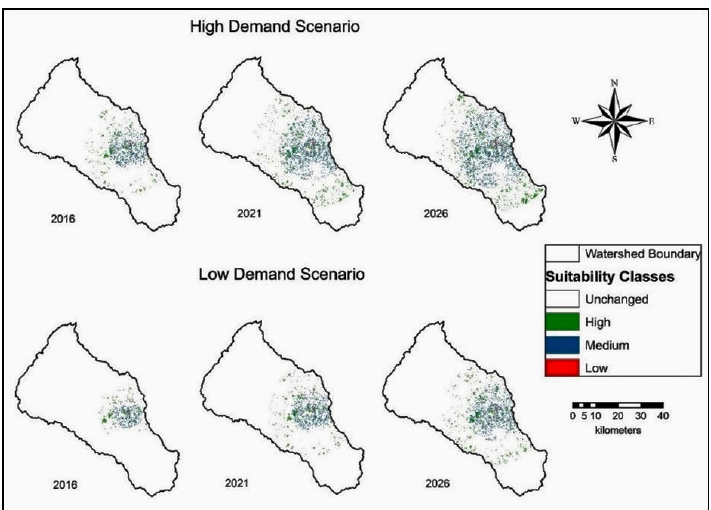
Figure 5. Projected land use under the scenarios of High and Low Demand for industrial wood pellets.: Shrestha and Dwivedi [48].